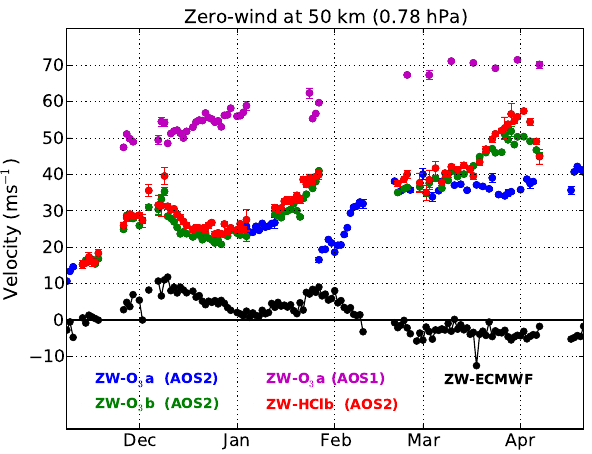
Fig. 5. Zero-wind for bias correction derived at 50km from the O 3 line in band-A using spectrometer 1 (magenta dots) and spec- trometer 2 (blue dots), the O 3 line in band-B and spectrometer 2 (green dots) and HCl line in band-B (red dots) along with the zero- wind computed with the paired ECMWF winds. The error bar cor- responds to the retrieval errors of the averaged profiles (1- σ ). The zero-wind includes the subtraction of the ECMWF